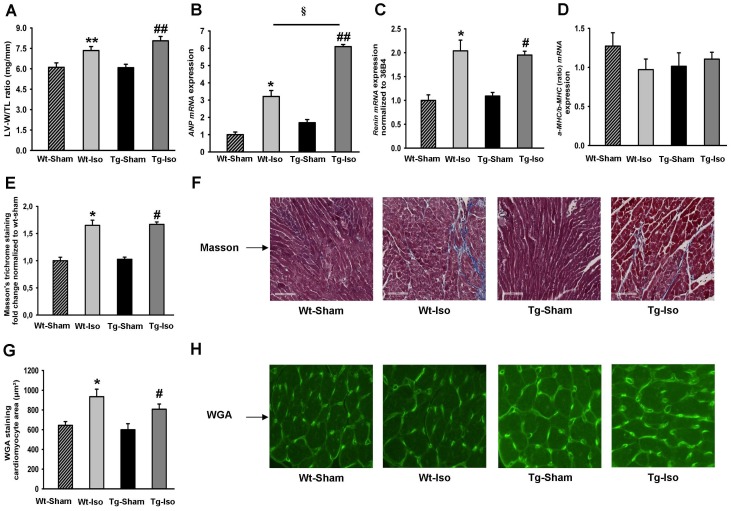
Assessment of isoproterenol induced cardiac hypertrophy in (P)RR transgenic mice.A) Left-ventricular weight (LV-W) to tibia length (TL)in adult Wt and Tg mice subjected to saline or ISO infusion for 28 days (N = 7 mice in each group). B) ANP mRNA expression (normalized to 36B4) in adult Wt and Tg mice subjected to saline or ISO infusion for 28 days (N = 7 mice in each group). C) Renin mRNA expression (normalized to 36B4) in adult Wt and Tg mice subjected to saline or ISO infusion for 28 days (N = 7 mice in each group). D) α-MHC/β-MHC (ratio) mRNA expression (normalized to 36B4) in adult Wt and Tg mice subjected to saline or ISO infusion for 28 days (N = 7 mice in each group). E and F) Masson’s trichrome staining (bar size 100 µm) to assess myocardial fibrosis in adult Wt and Tg mice subjected to saline (sham procedure) or ISO infusion for 28 days; E: quantification, and F: typical examples of Masson’s trichrome staining. G and H) FITC-WGA staining to assess myocyte hypertrophy in adult Wt and Tg mice subjected to saline (sham procedure) or ISO infusion for 28 days; G: quantification, and H: typical examples of FITC-WGA staining. *P<0.05, **P<0.01, sham vs. ISO between Wt mice; #
P<0.05, ##
P<0.01, sham vs. ISO between Tg mice and §
P<0.05, ISO treatment between Wt and Tg mice.